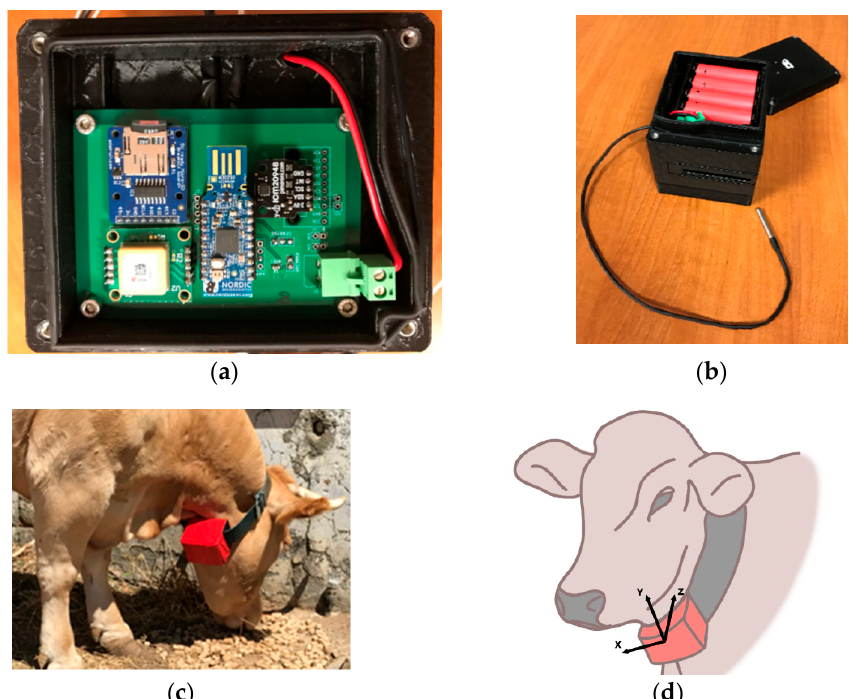
Figure 2. Collar developed for data collection. ( a ) PCB with electronic components; ( b ) collar batteries and temperature sensor; ( c ) collar with belt placed on the cow’s neck; ( d ) IMU axis orientation in the collar.